Question: Describe this figure in one sentence.
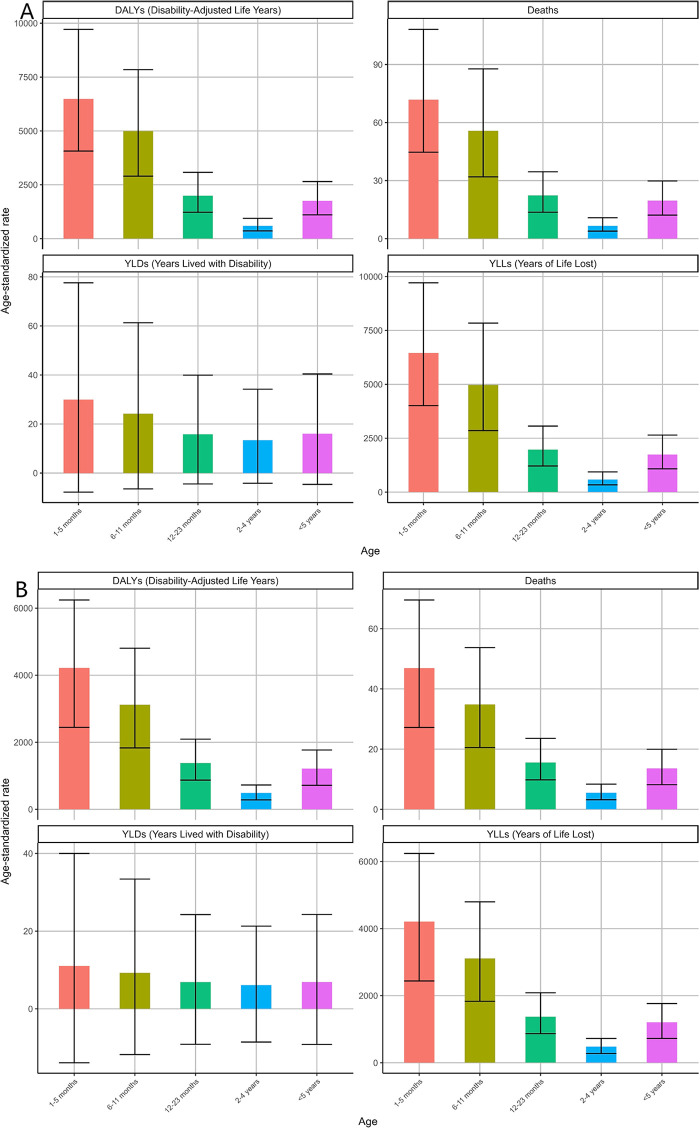
Answer: Age distribution of age-standardized rates of DALYs, deaths, YLDs, and YLLs from diarrheal diseases attributable to different risk factors in 2021. (A) Wasting; (B) stunting.